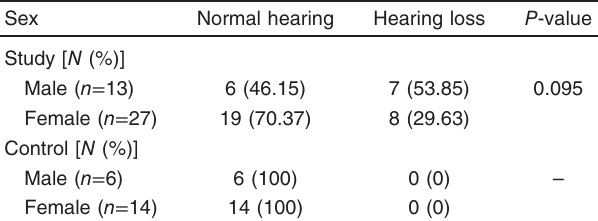
Table 3 Number and percentage of participants with hearing loss in the study and control groups according to their sex distribution